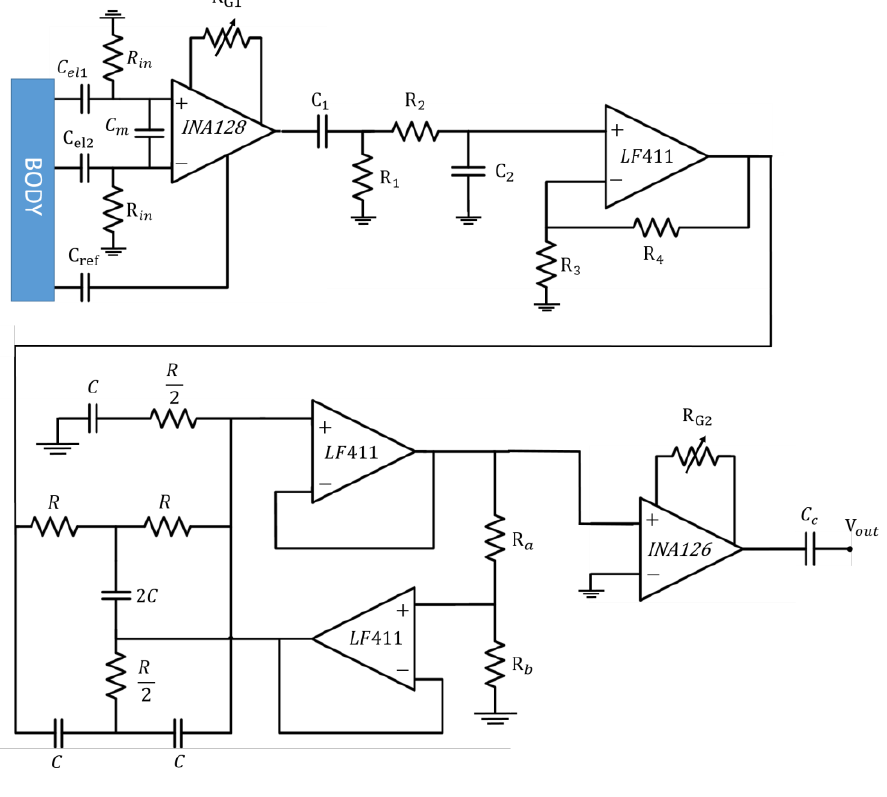
Figure 8. Circuit schematic of the whole analogue system. Table 1. Component values.